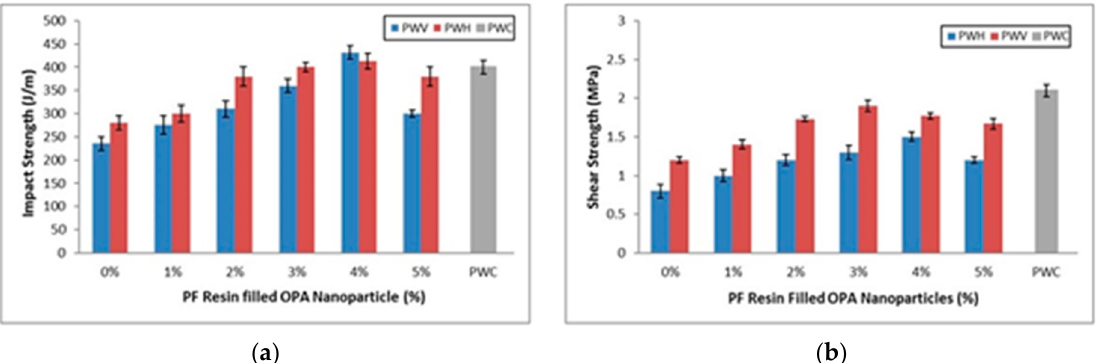
Figure 8. a ) Shear strength and b ) impact strength of PWV and PWH with different loading of PF filled OPA nanoparticles compared to